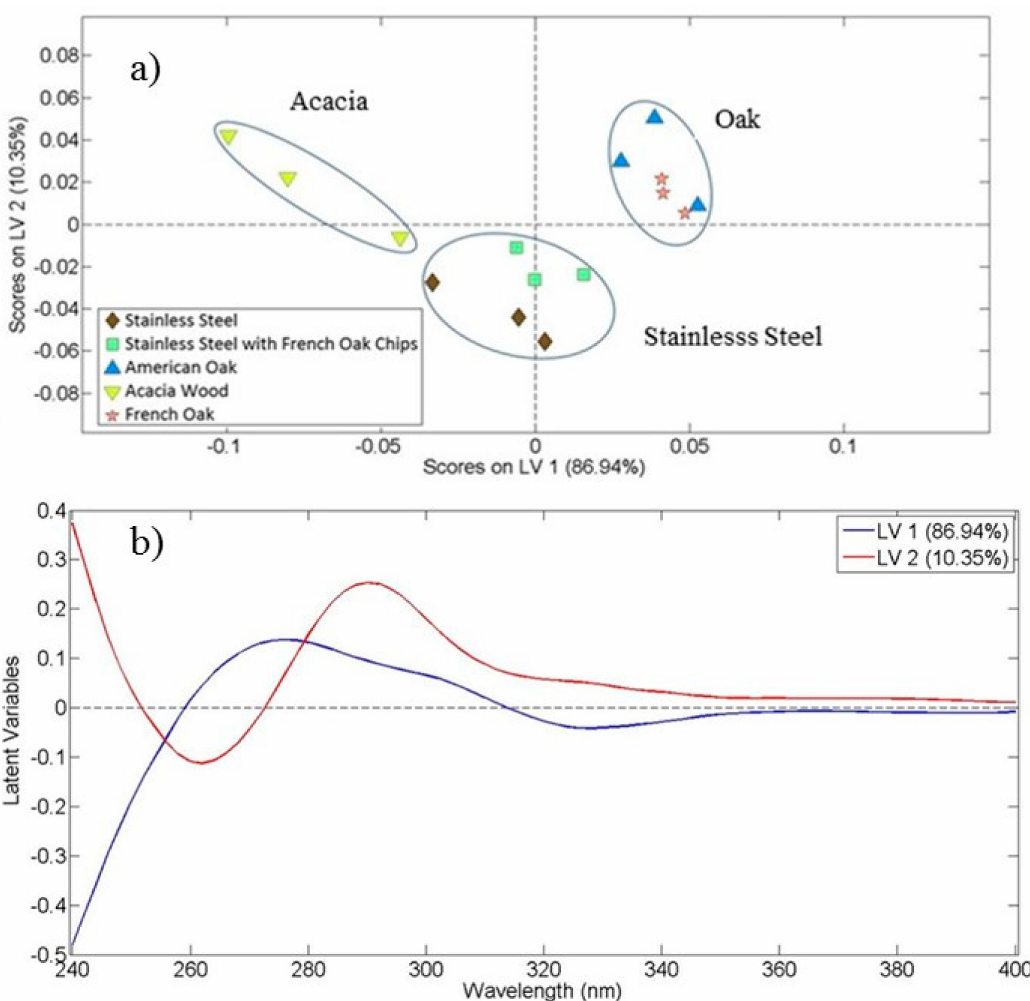
Figure 5. Maturation container discrimination. ( a ) Score plot of the first and the second latent variables resulting from the OPLS-DA application on ultraviolet spectral data of the white wine Vilana samples (2012 vintage). The assignment of each category of wine samples is shown in the inset, and ( b ) Corresponding loading plot. Latent variable 1 is designated by the blue line and latent variable 2 by the red line.